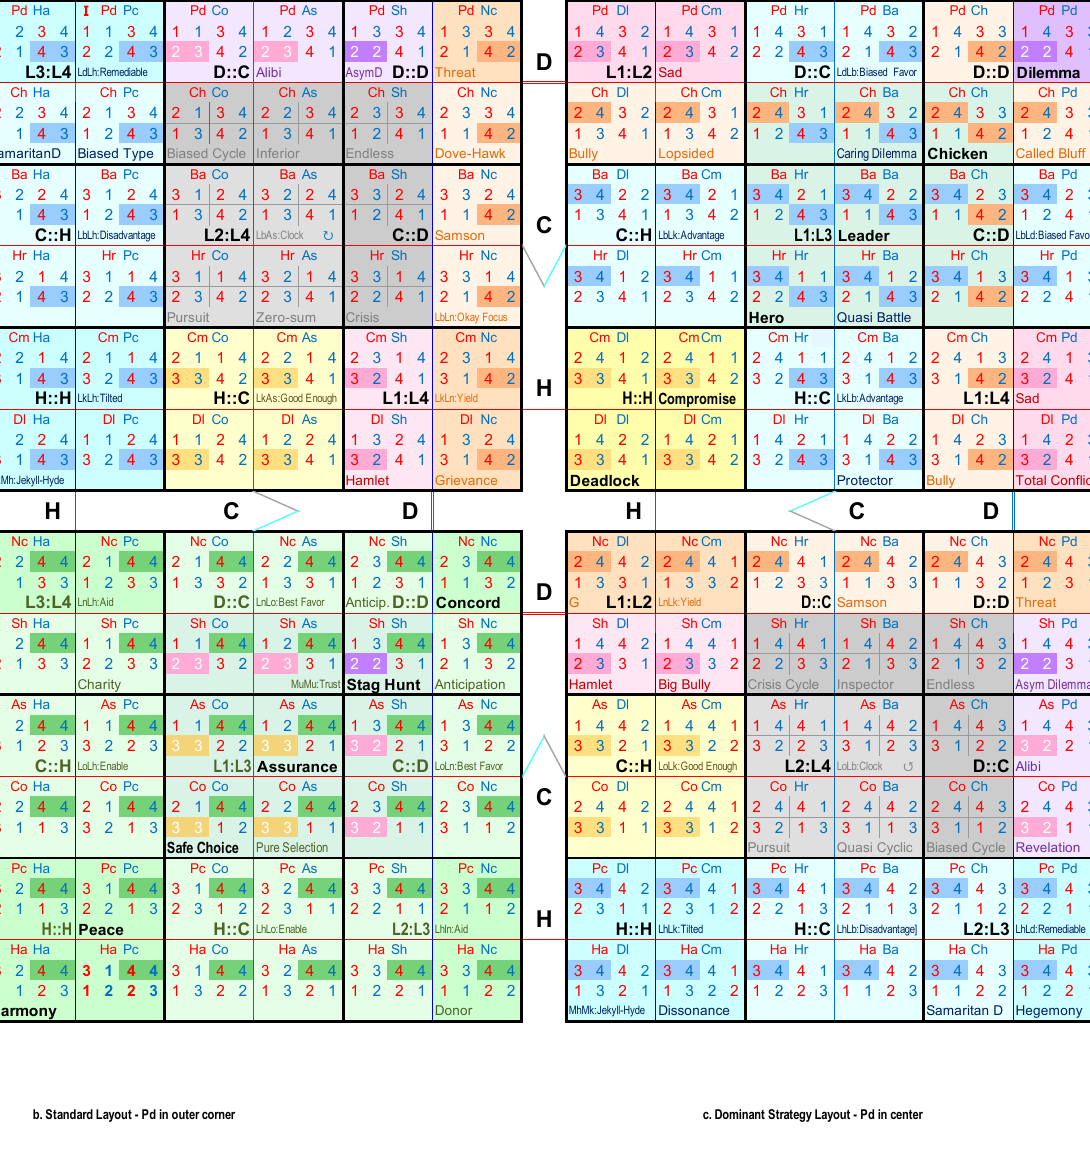
Figure A3 . Hotspots and pipes in a “standard layout” of the topology of 2x2 games with Prisoner’s Dilemma in an outer corner. Figures A3b and A3c show how “scrolling” the display of the torus-shaped layer moves Prisoner’s Dilemma from an outer corner to an inner corner. This splits open tiles and creates the dominant strategy layout shown in Figure A4.